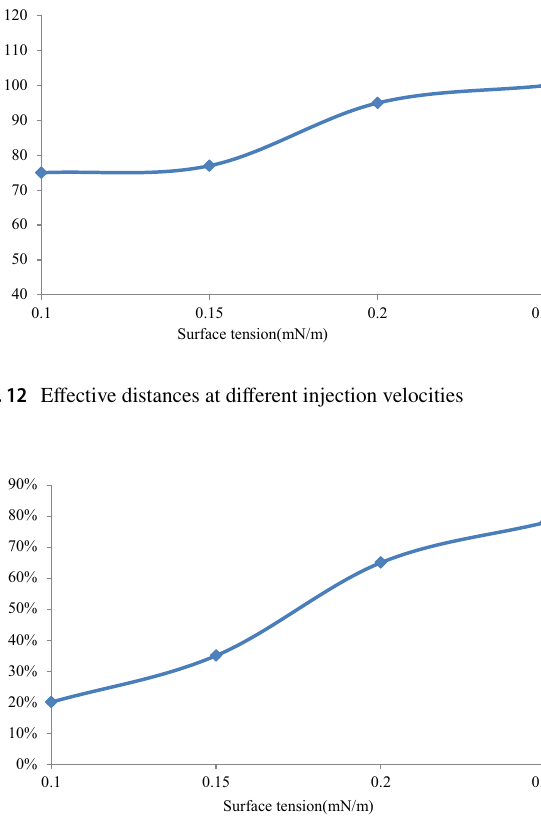
Fig. 13 Filling ratios at different injection